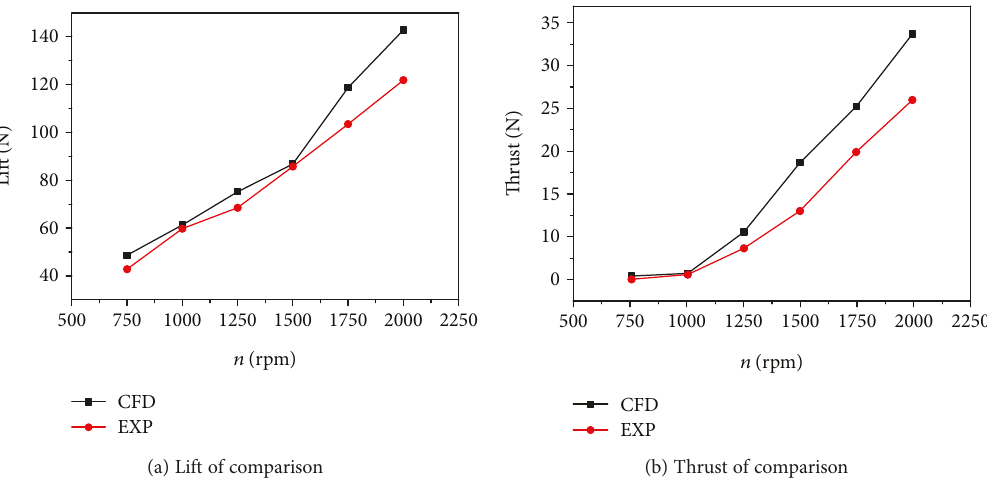
Figure 9: Comparison chart of the